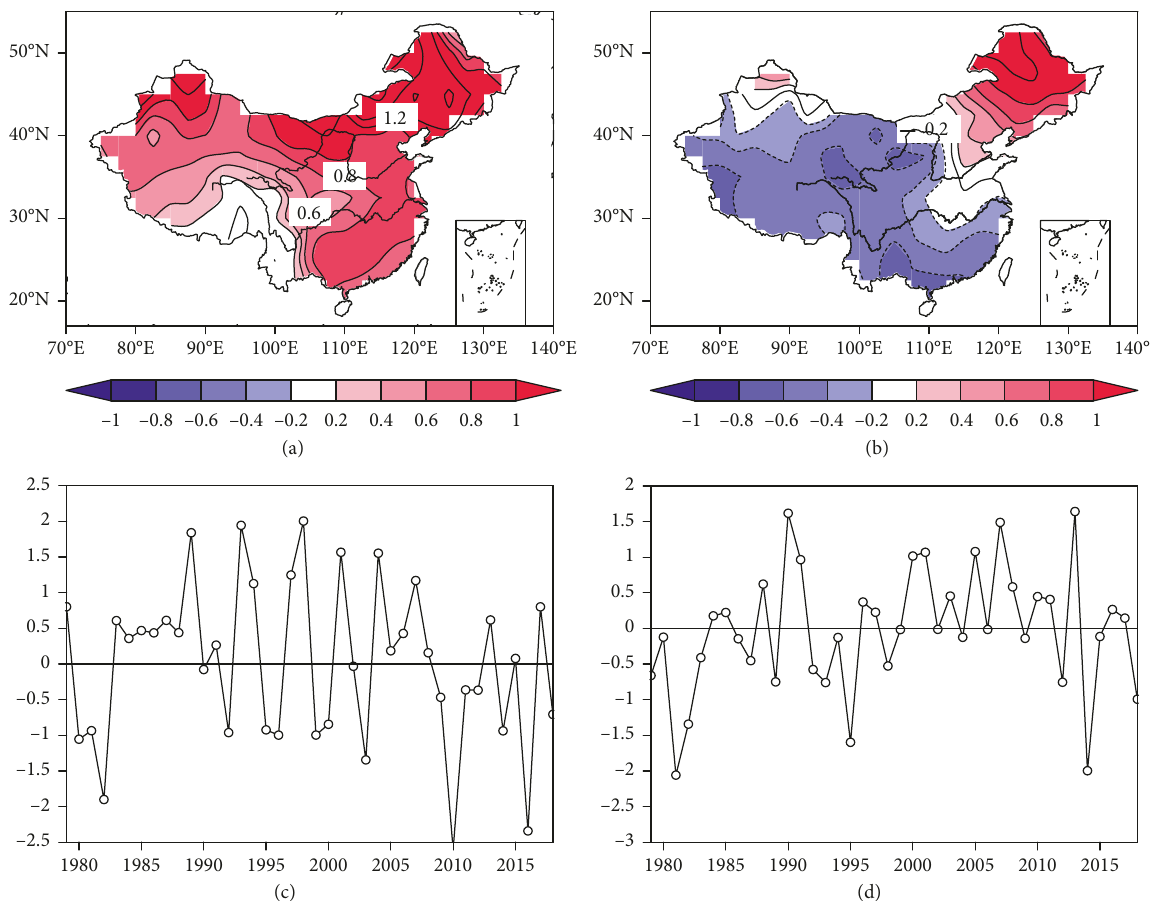
Figure 4: Spatial patterns of the first (a) and the second (b) EOF modes of the winter surface air temperature anomalies at 160 stations in China from 1979 to 2018 (unit: ° C); the corresponding normalized time coefficients for the first (c) and the second (d) EOF modes. Table 1: Correlation coefficients between the month-to-month detrended (original) BKI, ASI, PC1, and PC2. BKI EOF